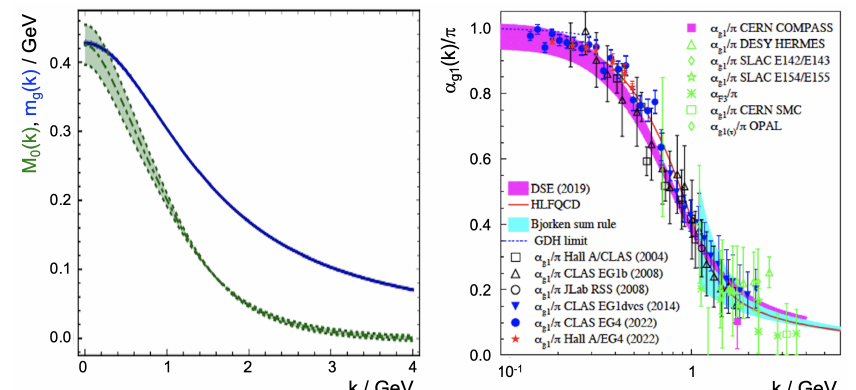
Figure 2. ( Left ): CSM predictions for the momentum dependence of the dressed-gluon (blue solid) and quark (green dot-dashed) masses [9–11]. The associated like-colored bands express the uncertain- ties in the CSM predictions. ( N.B . Since the Poincaré-invariant kinetic energy operator for a vector boson has mass–dimension two and that for a spin-half fermion has mass–dimension unity, then for m 2 p / k 2 → 0, M 0 ( k ) ∝ 1/ k 2 and m 2 g ( k ) ∝ 1/ k 2 , up to ln k 2 corrections). ( Right ) CSM prediction [3] (magenta band) for the process-independent QCD running coupling ˆ α ( k ) compared with the empiri- cal results [4] for the process-dependent effective charge defined via the Bjorken sum rule, which is prominent in deep inelastic